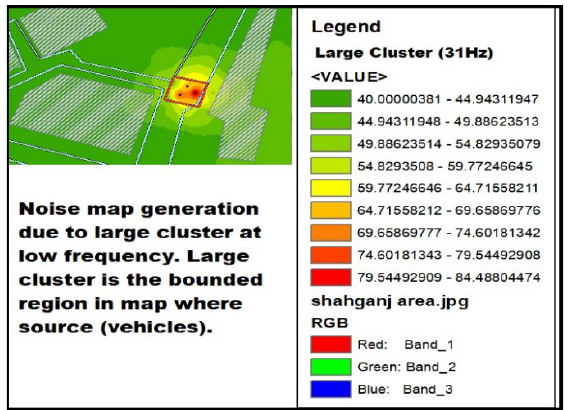
Figure 13. Noise map for the large cluster at large freq. 16 kHz.